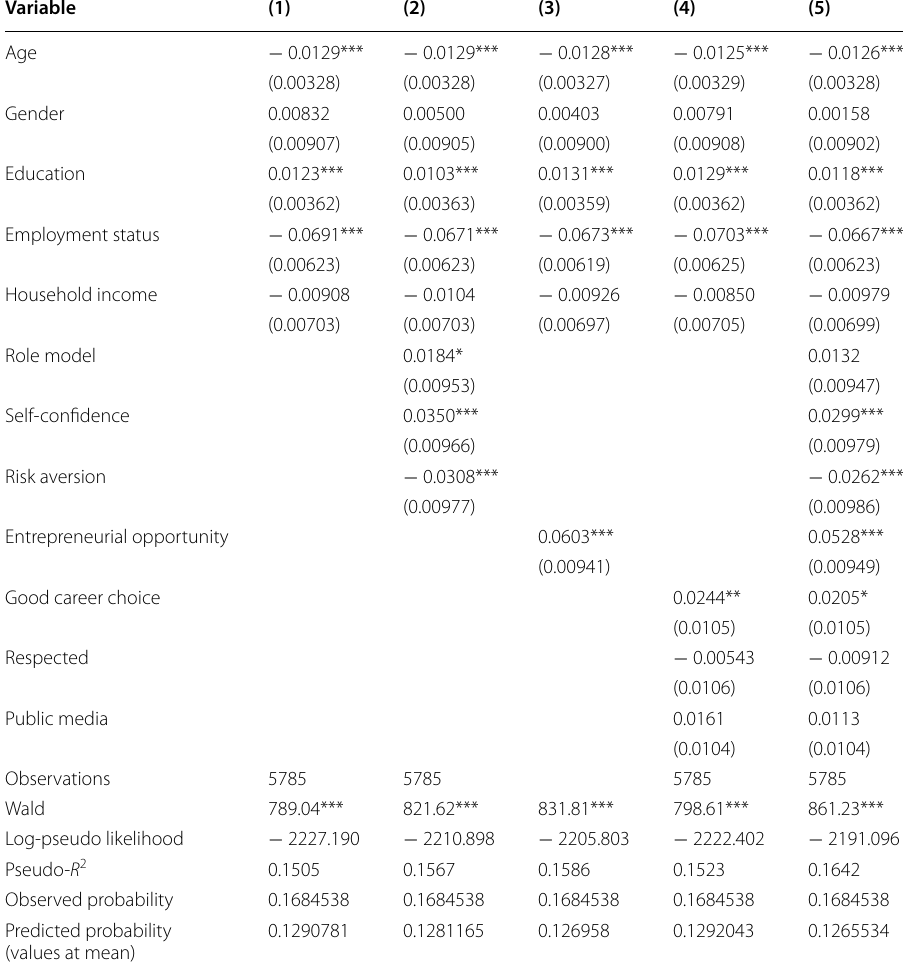
Table 8 Probit regression results, marginal